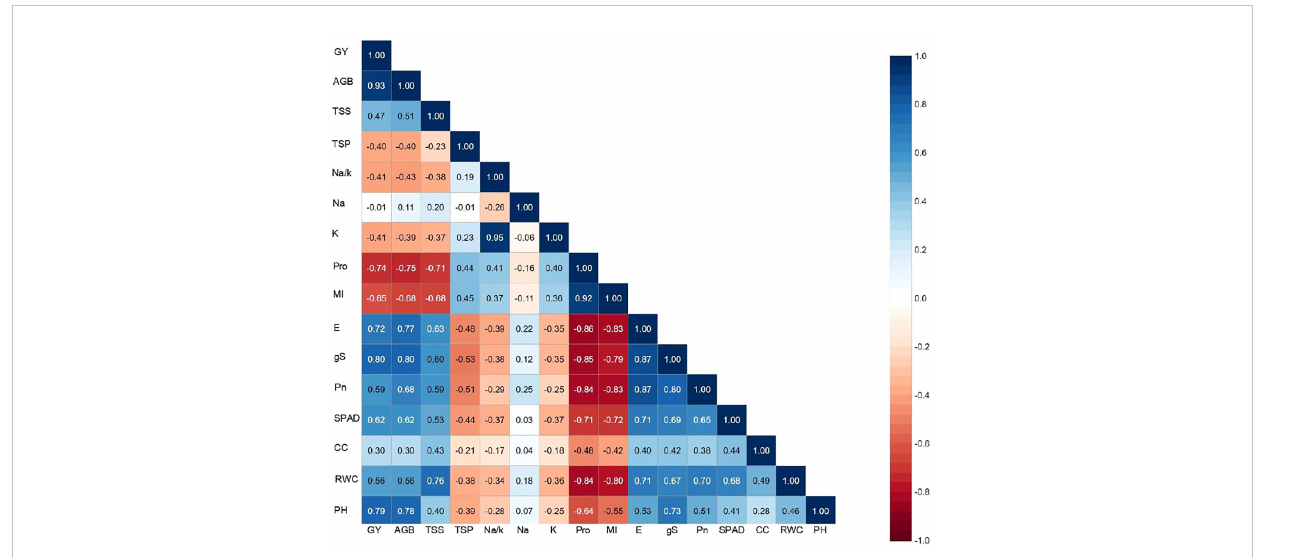
FIGURE 3 Traits association among morpho-physiological and yield parameters under irrigation induced salinity stress in pearl millet (averaged across evaluated hybrids and inbred lines). PH, plat height; RWC, relative water content; MI, membrane injury; CC; chlorophyll content; SPAD, soil plant analysis development (SPAD) chlorophyll meter reading; Pn, photosynthetic rate; gS, stomatal conductance; E, transpiration rate; Pro, proline; SP, soluble proteins; SS, soluble sugars; Na, sodium content; K, potassium content; Na/K, sodium to potassium ratio; AGB, above ground